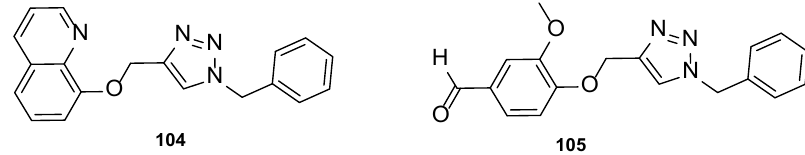
Figure 50. Chemical structure for compounds 104 and 105 [135].